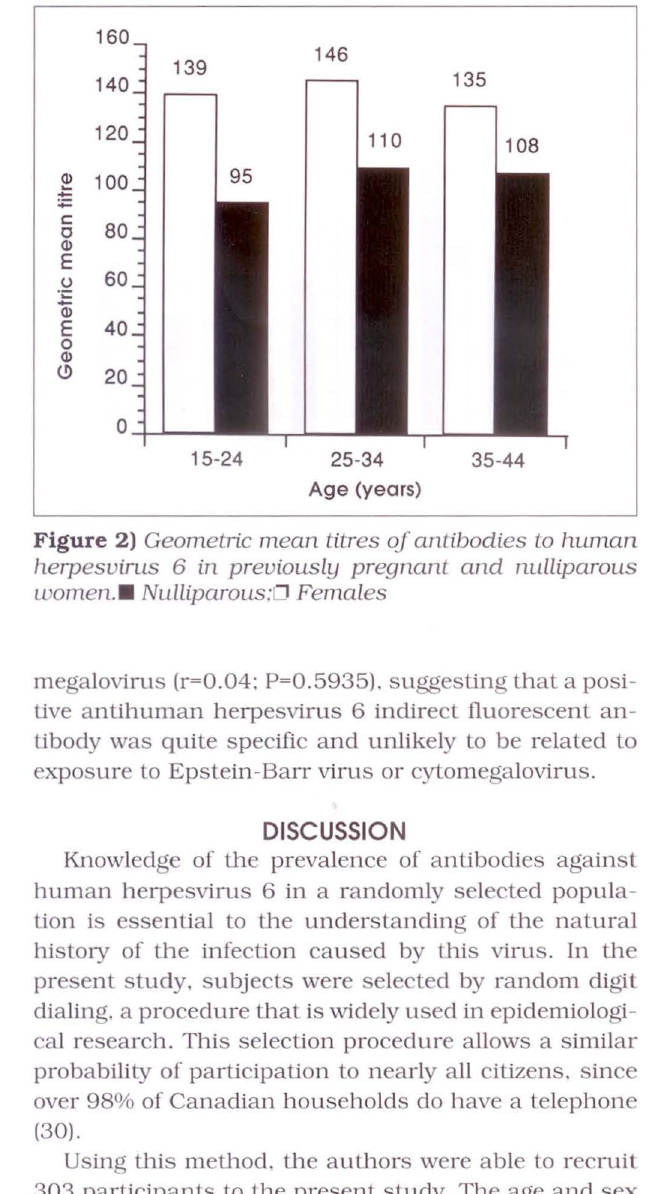
Figure 2) Geometric mean utres of antibodies io htLman herpesvirus 6 in previously pregnant and nulliparous women. • Nulliparous:O Females